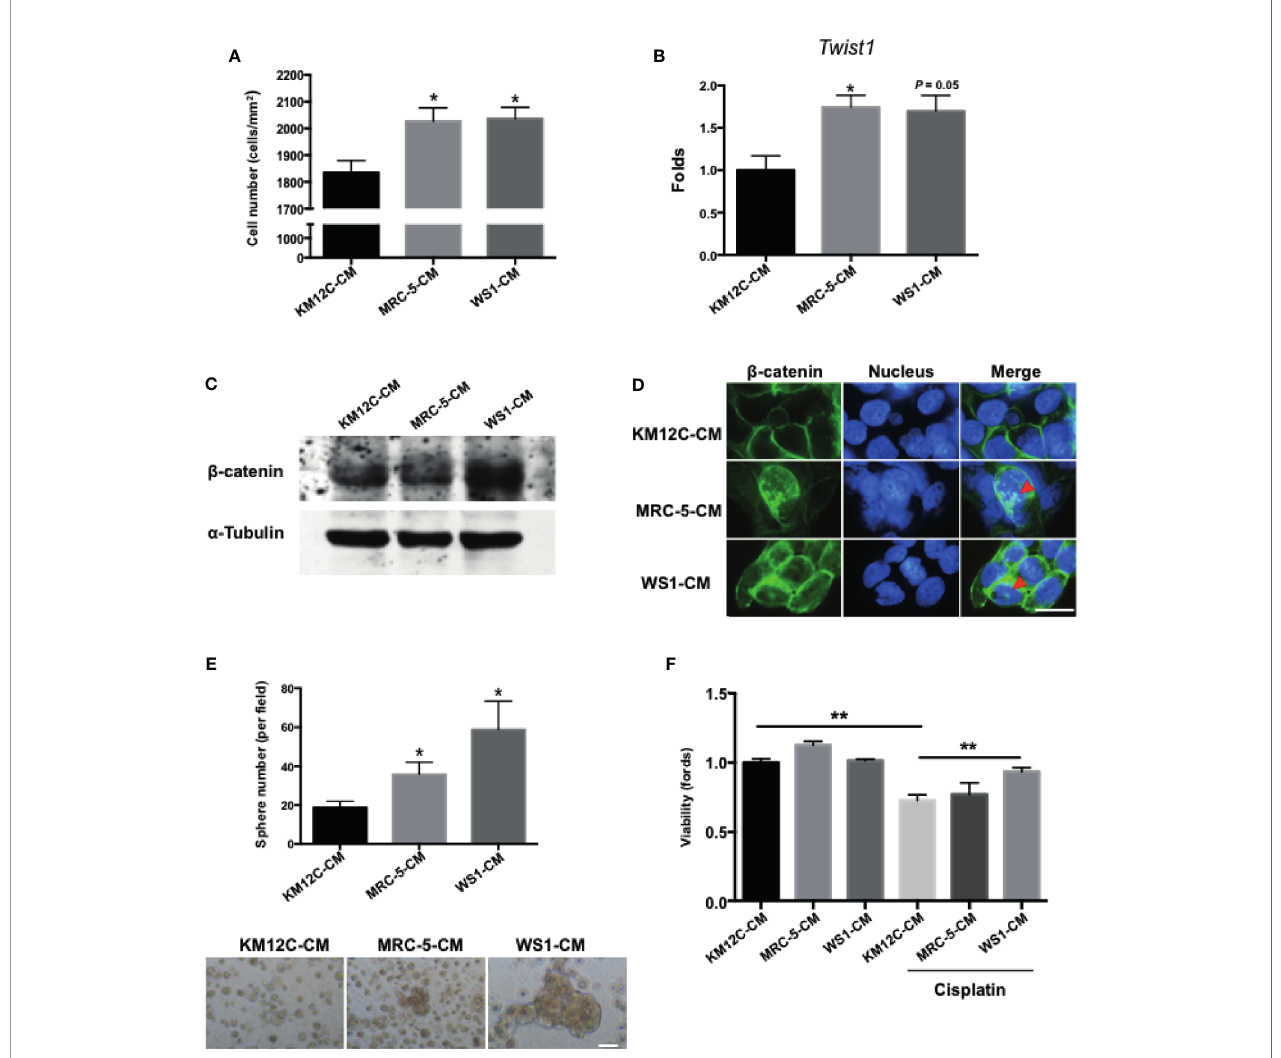
FIGURE 1 | Fibroblast-derived paracrine factors signi fi cantly promote multiple cancer-initiating cell (CIC) features in colorectal cancer (CRC) cells. (A) Invasion capacity of the CRC cell line KM12C (KM12C) after culturing in conditioned media (CM) of two human fi broblast cell lines MRC-5 and WS1 for 48 hours; control, KM12C-CM. (B) Quantitative real-time PCR (qPCR) analysis for the gene expression levels of Twist1 in KM12C after culturing in MRC-5- or WS1-CM; control, KM12C-CM. (C) Western blot for the b -catenin levels in KM12C after culturing in MRC-5- or WS1-CM; control, KM12C-CM. (D) Immuno fl uorescent (IF) staining for b -catenin subcellular localization (green fl uorescence) in KM12C after culturing in MRC-5- or WS1-CM; control, KM12C-CM; arrows indicate nuclear b -catenin. Hoechst 33342 was used to detect cell nuclei (blue fl uorescence); scale bar, 10 m m. (E) Sphere formation capacity of KM12C after culturing in MRC-5- or WS1-CM for 72 hours; control, KM12C-CM. Quantitative results (top panel) and representative images (bottom panel) are shown; scale bar, 30 m m. (F) Drug resistance capacity of KM12C to cisplatin (25 µM) after pretreatment with either MRC-5- or WS1-CM (control, KM12C-CM) for 24 hours. Cell viability was assessed 48 hours after drug treatment. All results are shown as mean ± SEM of three independent experiments. * p < 0.05 and ** compared to